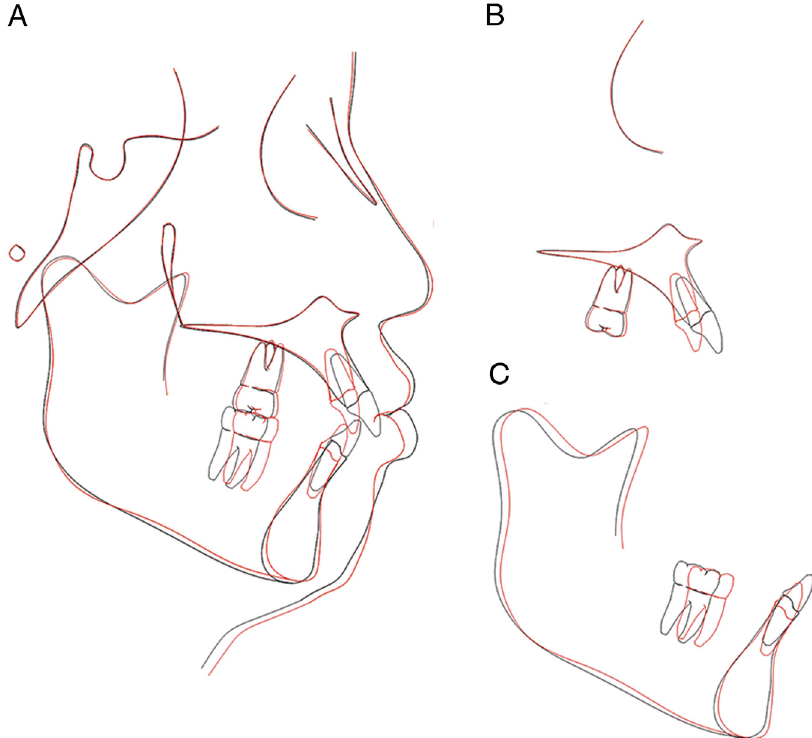
Figure 13. Cephalometric superimpositions of the initial (black), final (red) lateral cephalometric tracings: (A) centered on the cranial base; (B) centered on the palatal plane; (C) centered on the mandibular symphysis.